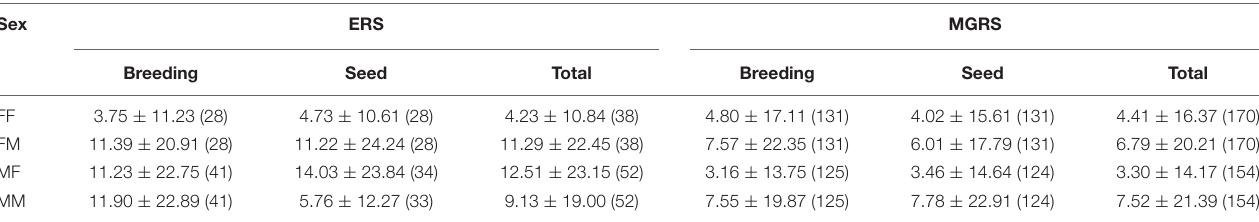
TABLE 3 | Average core-area overlap (%, mean ± SD , sample size between parentheses) of male and female Eurasian red squirrels (ERS) and Mt. Graham red squirrels (MGRS) by season (breeding and seed) and independent of season